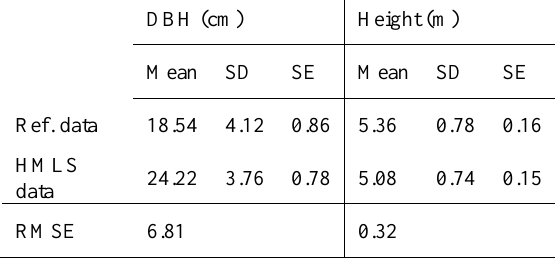
Table 2. A summary of the reference data and estimated parameters from HMLS data extracted by using 3D